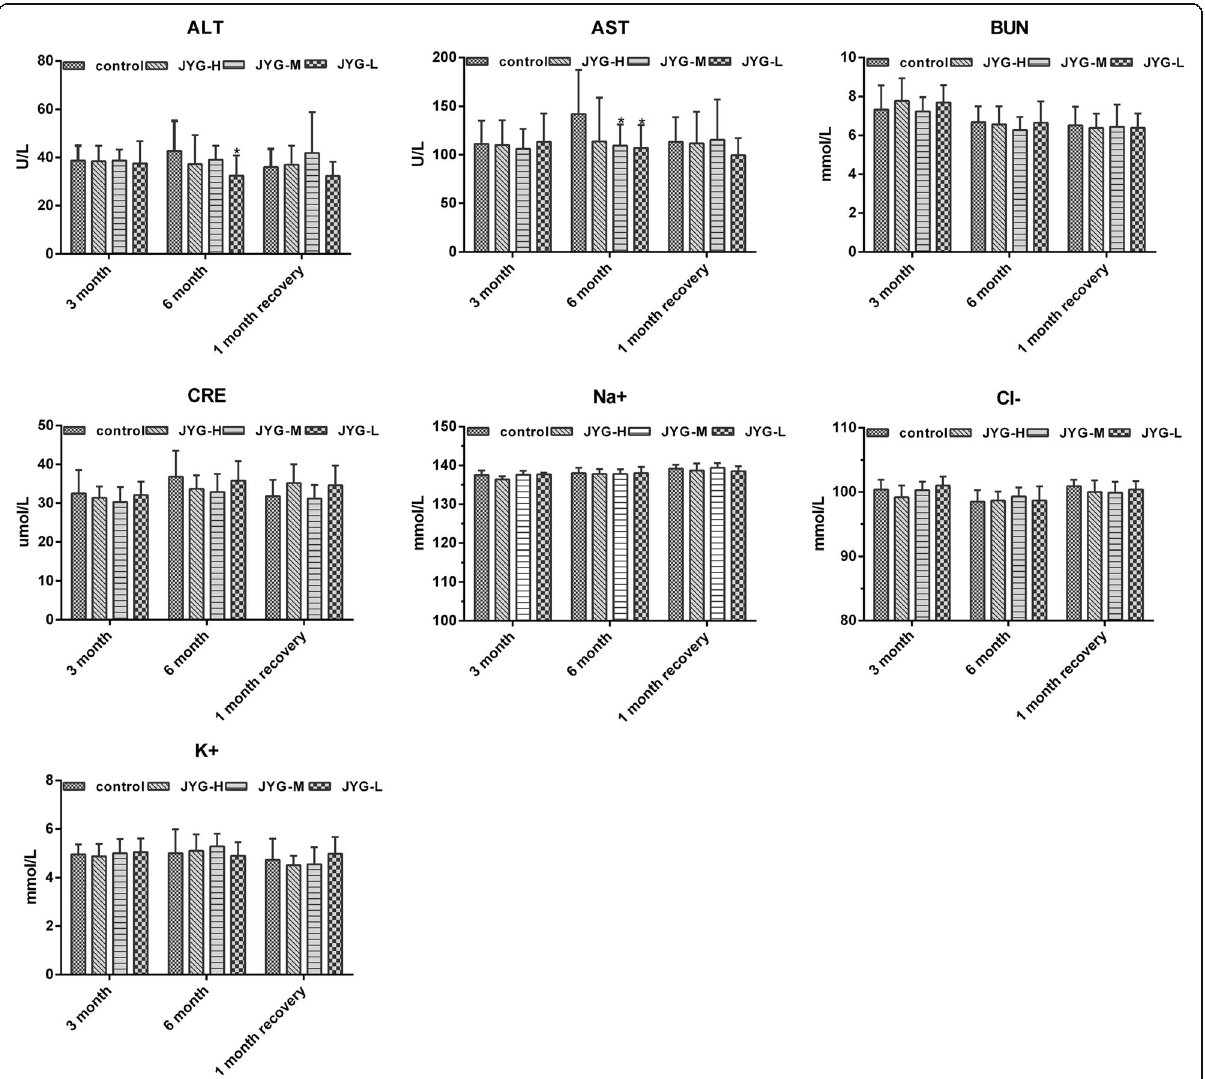
Fig. 9 Biochemical parameters in the control and JYG-treated groups in the chronic toxicity test. Note: JYG-H, JYG-M, JYG-L: Jueyin granules high-dose, medium-dose, low-dose group, respectively; ALT: alanine aminotransferase; AST: aminotransferase; BUN: blood urea nitrogen; CRE: creatinine; Na + : Sodium ion; Cl − : Chloride ion; K + : Potassium ion. The values are expressed as mean±SEM (n=10 rats for 3 months; n=17 – 19 rats for 6 months; n=10 rats for 1 month recovery). * P <0.05 statistically significant compared to control